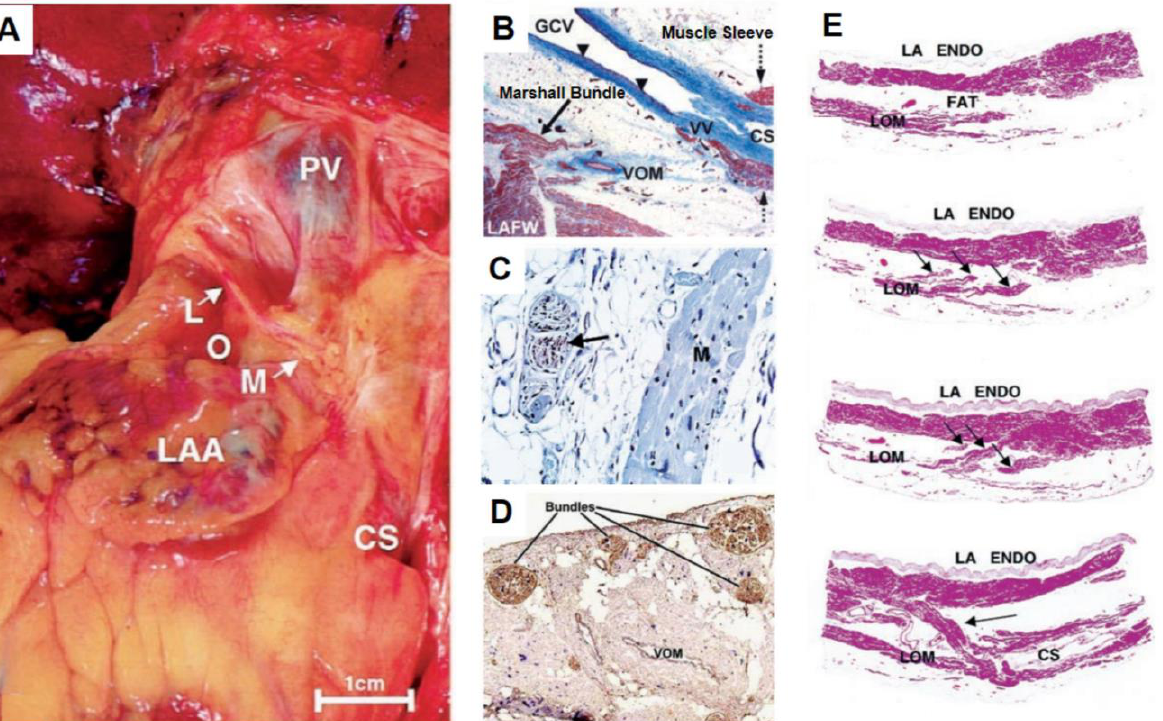
Figure 1. Gross photo ( A ) and histochemical staining ( B – E ) showing the anatomy of the ligament of Marshall. ( B ) The CS myocardial sleeve is shown by Masson’s trichrome staining of the CS and VOM, which ends at the valve of Vieussens (VV). No myocardial sleeve is seen in the great cardiac vein (GCV). ( C ) The nerve (brown staining-arrow) is shown by positive avidin-biotin-peroxidase immunohistochemical staining for tyrosine. (×120). ( D ) Dual-staining of the nerve bundles of the LOM for DBH (blue) and ChAT (brown) showing that cholinergic nerve fibers are predominant (×5). ( E ) Hematoxylin-eosin staining showing the tracts of the LOM. Three tracts (arrows) emerging from the LOM are shown by subserial sections, which eventually enter the atrial wall. The last panel shows a section from the lower end of the LOM. The tract inserts into the left atrial wall (arrow) and CS ( ×10). CS, coronary sinus; ChAT, choline acetyl transferase; DBH, dopamine β -hydroxylase; LAA, left atrial appendage; LAFW, left atrial free wall; LOM, ligament of Marshall; M, myocardium; F, fat; PV, pulmonary vein; VOM, vein of Marshall (reproduced and modified with permission from Kim et al. [15], Chou et al. [16], and Ulphani et al. [17]). The LOM is richly innervated by both cholinergic and adrenergic nerves and ganglion cells. Different portions of the LOM present different cholinergic-to-adrenergic